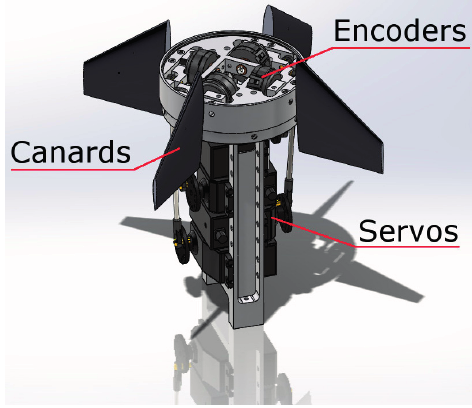
Figure 6. Final actuation assembly for